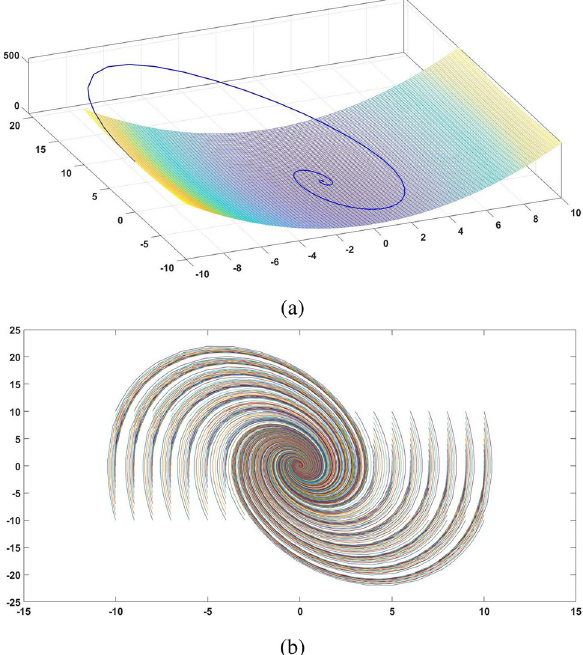
Figure 6: Lyapunov function convergence: ( a ) 3 - D graph and ( b ) 2 - D graph.